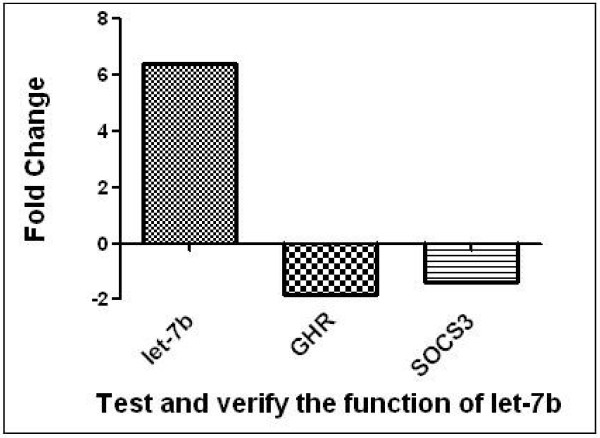
Functional validation of let-7b inhibitingGHRin anin vitrocell system. pcDNA-EGFP-pre-let-7b was transfected into the DF-1 cell line compared with cells transfected with the control plasmid.